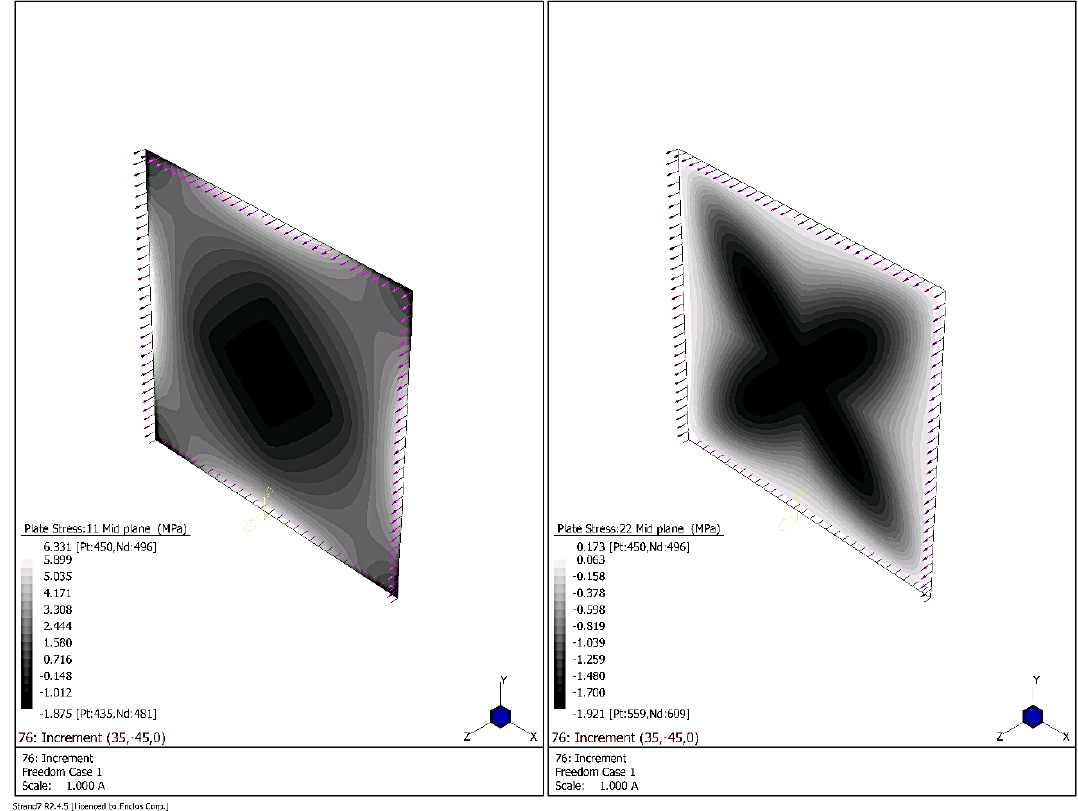
Fig. 10 Membrane stresses present in the 1500mm x 1500mm case including residual warping